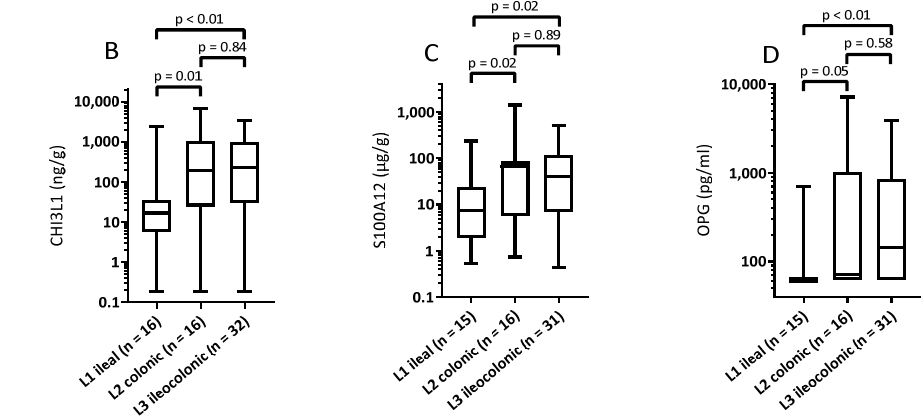
Figure 2. Fecal biomarker levels according to disease location in children with Crohn’s disease. Box plot with median, minimum, maximum 25th and 75th percentiles for levels of ( A ) calprotectin; ( B ) chitinase 3-like-1; ( C ) S100A12; and ( D ) osteoprotegerin.